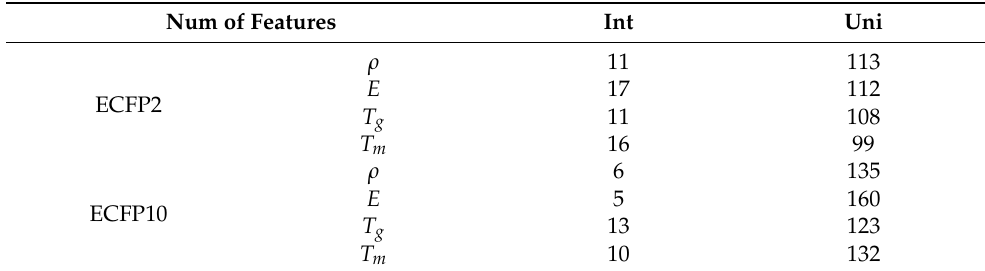
Table 2. Number of features in the intersection (Int) and union (Uni) sets for each property after the RF feature selection